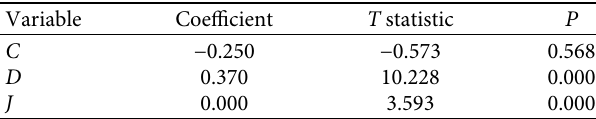
Table 8: Significance of coefficients (mean absolute values of the acceleration slopes).